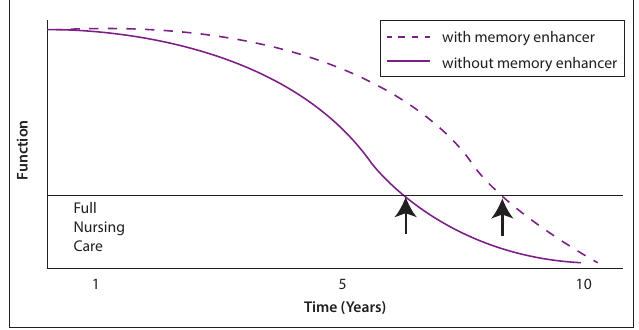
Fig. 1. Course of Alzheimer’s disease (with/out memory enhancer).